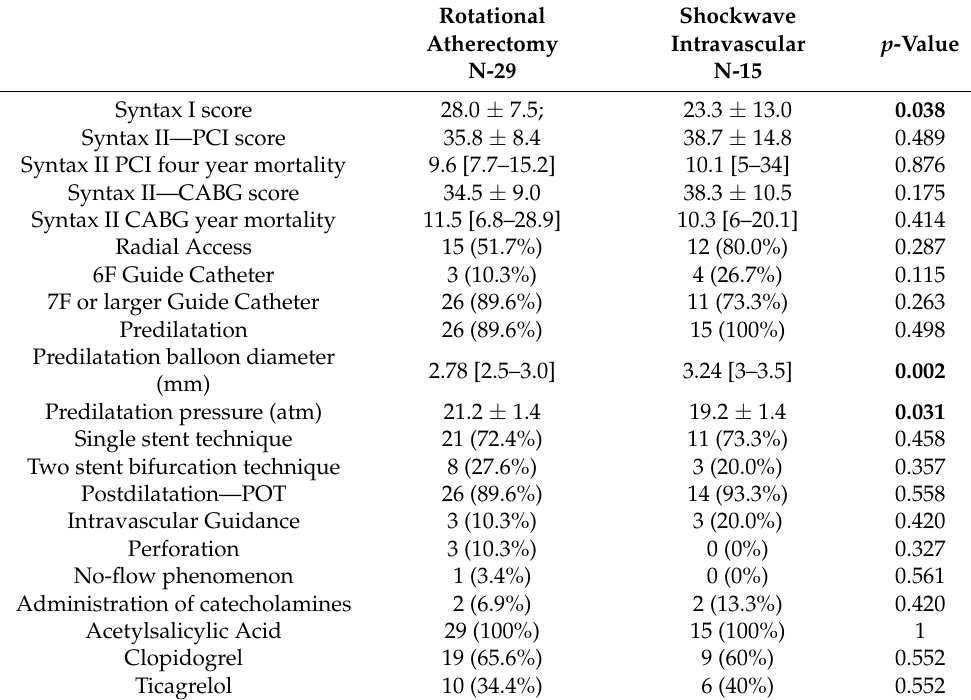
Table 2. The baseline procedural features of both study